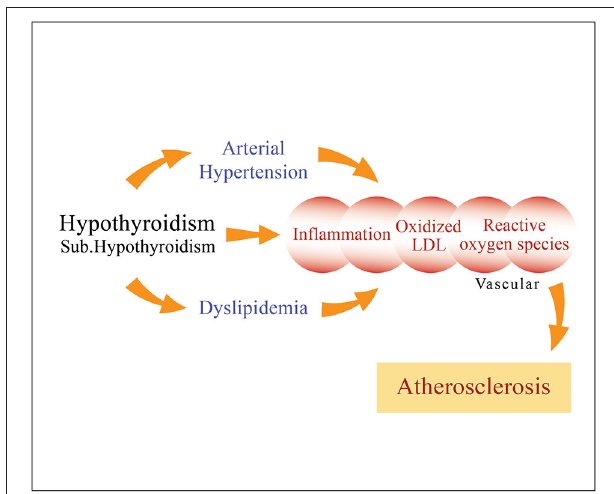
FIGURE 2 | Long-term overt hypothyroidism, as well as subclinical hypothyroidism to a lesser degree, when left untreated cause dyslipidemia and arterial hypertension (diastolic), as well as inflammation characterized by oxidative stress and generation of reactive oxygen species, which may induce endothelial dysfunction, thereby promoting